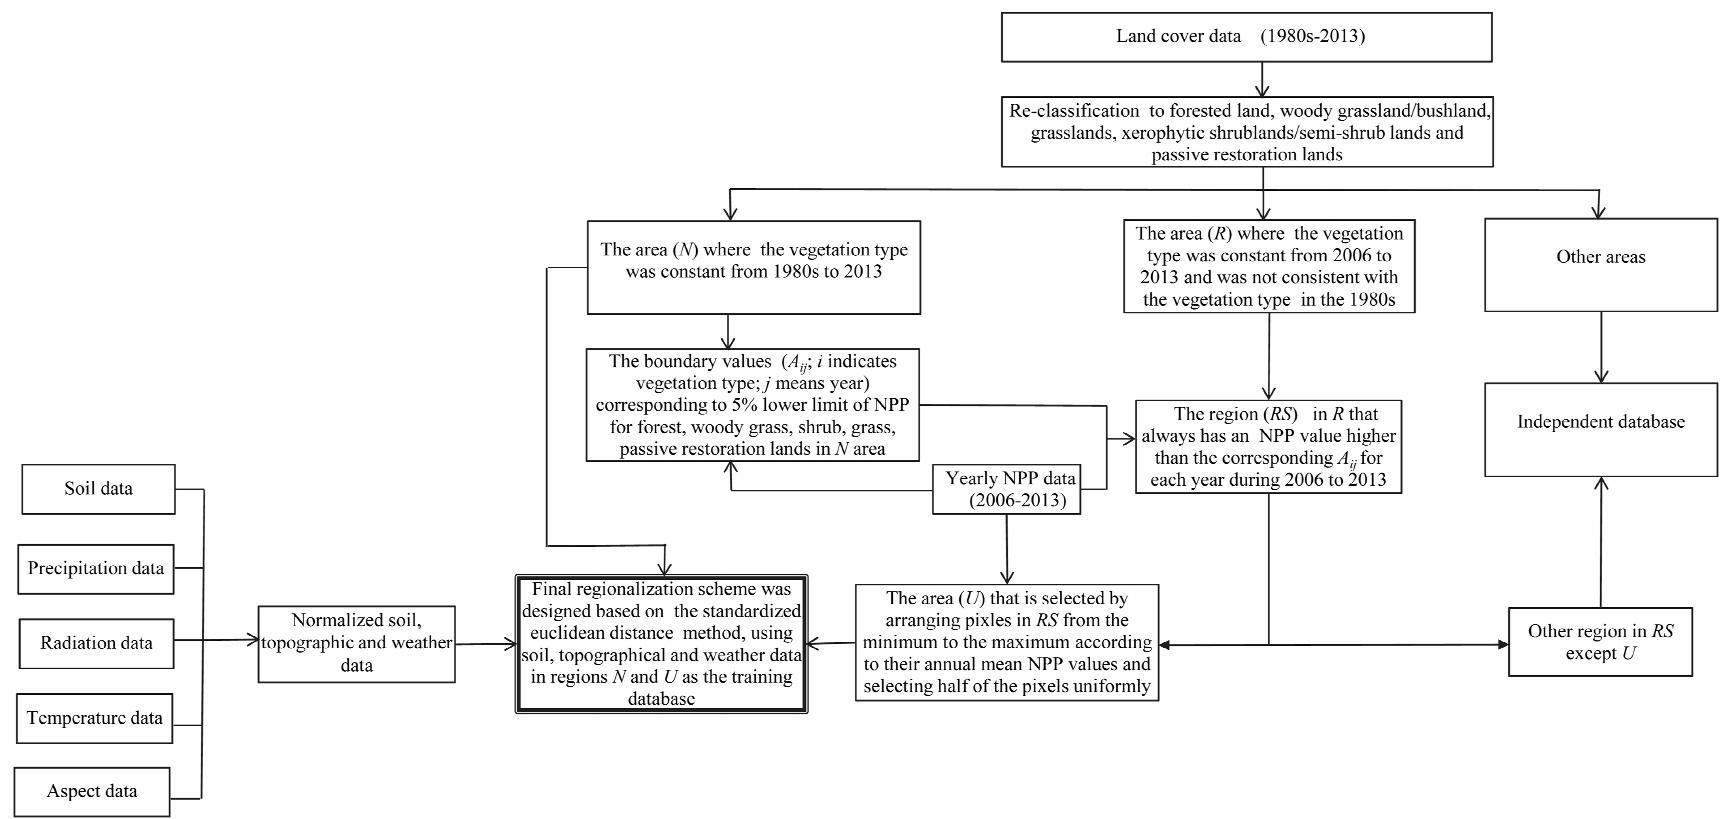
Figure 2. Flow chart illustrating the design of the vegetation restoration regionalization scheme.